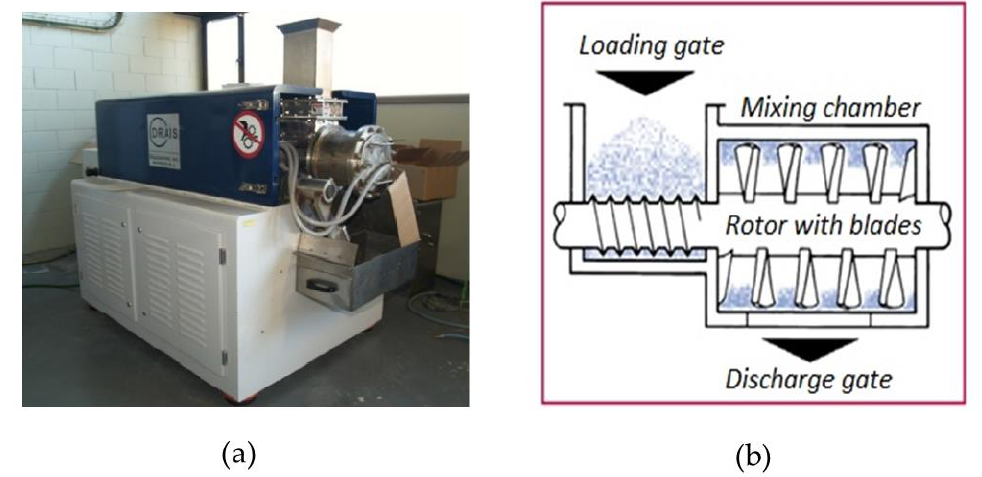
Figure 2. ( a ) Gelimat ® equipment, and ( b ) Schematic of Gelimat